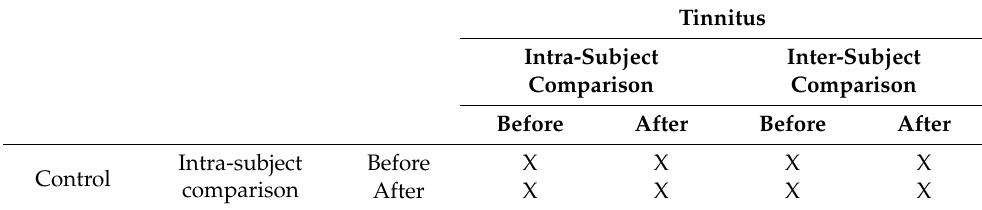
Table 2. Study groups. Tinnitus vs. Control